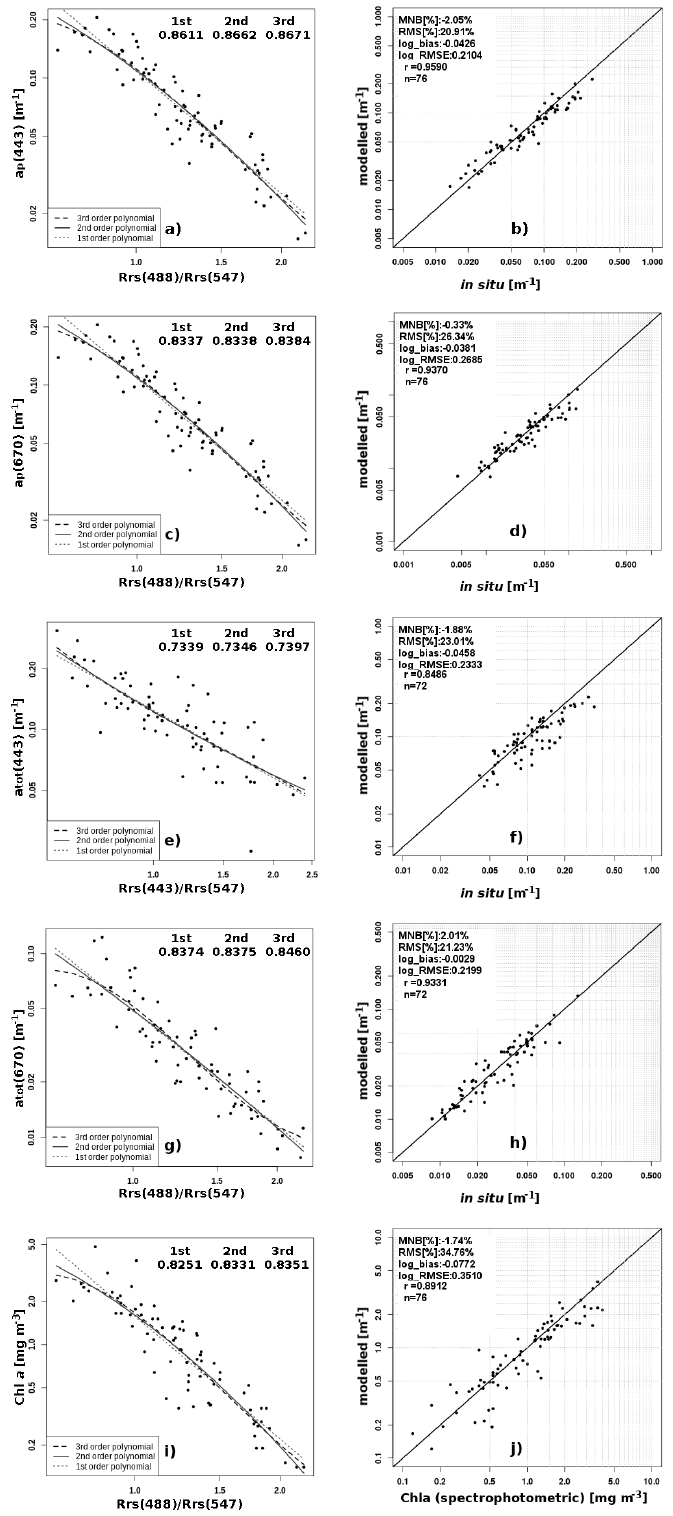
Figure 5. Regression lines fitted on the basis of development dataset (left) and scatterplots of modelled values against reference datasets of in situ measurements (right). Absorption by particles at 443 nm ( a , b ), absorption by particles at 670 nm ( c , d ), total absorption at 443 nm ( e , f ), total absorption at 670 nm ( g , h ), chlorophyll a concentration ( i , j ). Predictions based on simulated MODIS